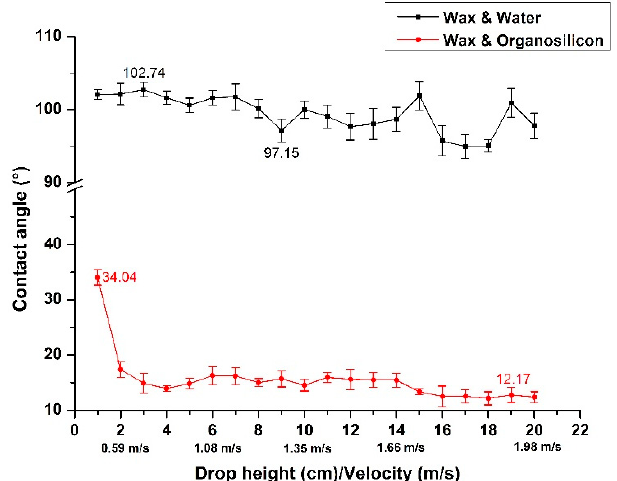
Figure 6. The variation of wettability with the increase of droplet falling height.